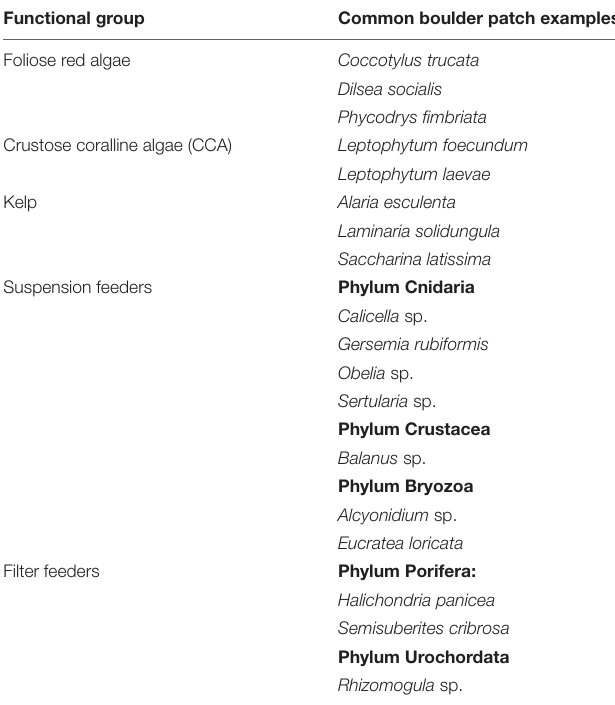
TABLE 1 | Common species and genera from the Boulder Patch associated with each functional group category used in community